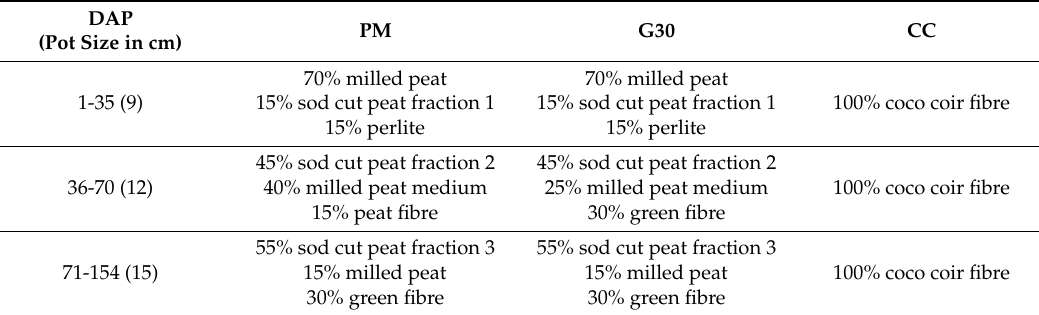
Table 1. Substrate composition of peat-mix (PM) growth media, peat-mix substituted with 30% green fibre (G30) growth media, pure coco coir fibre (CC) growth media and pot size during the experimental time from 03.04.2019 until 04.09.2019. Days after planting